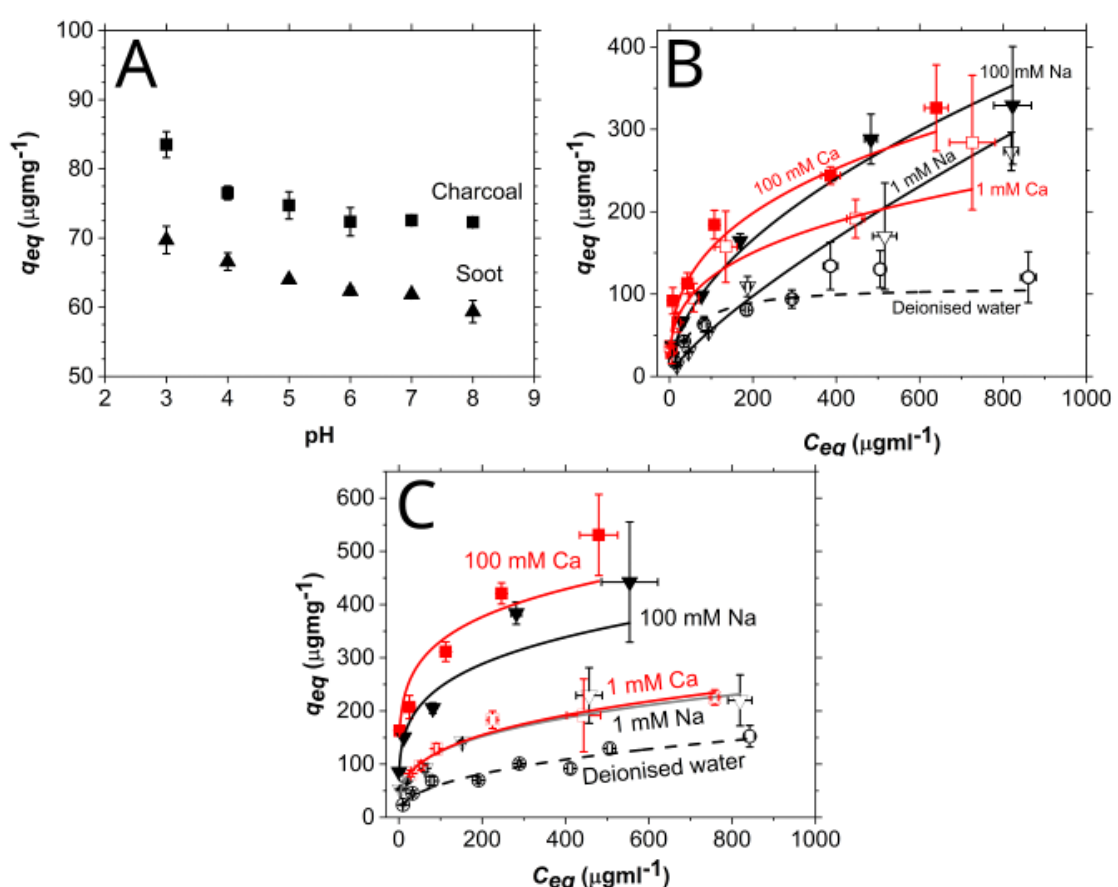
Figure 2 . A) DNA adsorption capacity decreases as pH increases in solution with 100 mM NaCl and